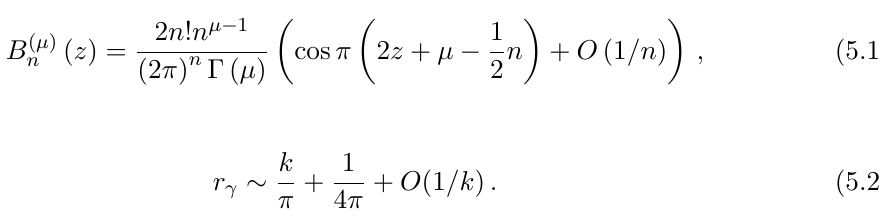
asymptotes to k=(cid:25) . This is exactly what was (cid:13)